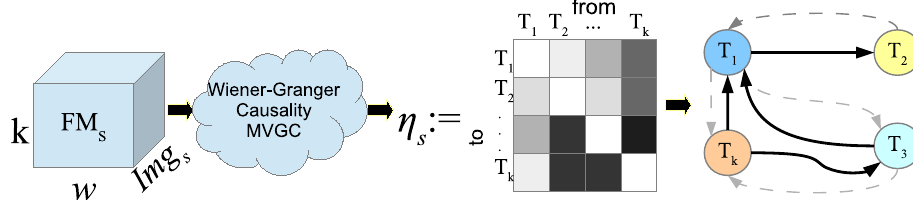
Figure 7. Generation of a texture-based causality relationship matrix, η s , using the WGC